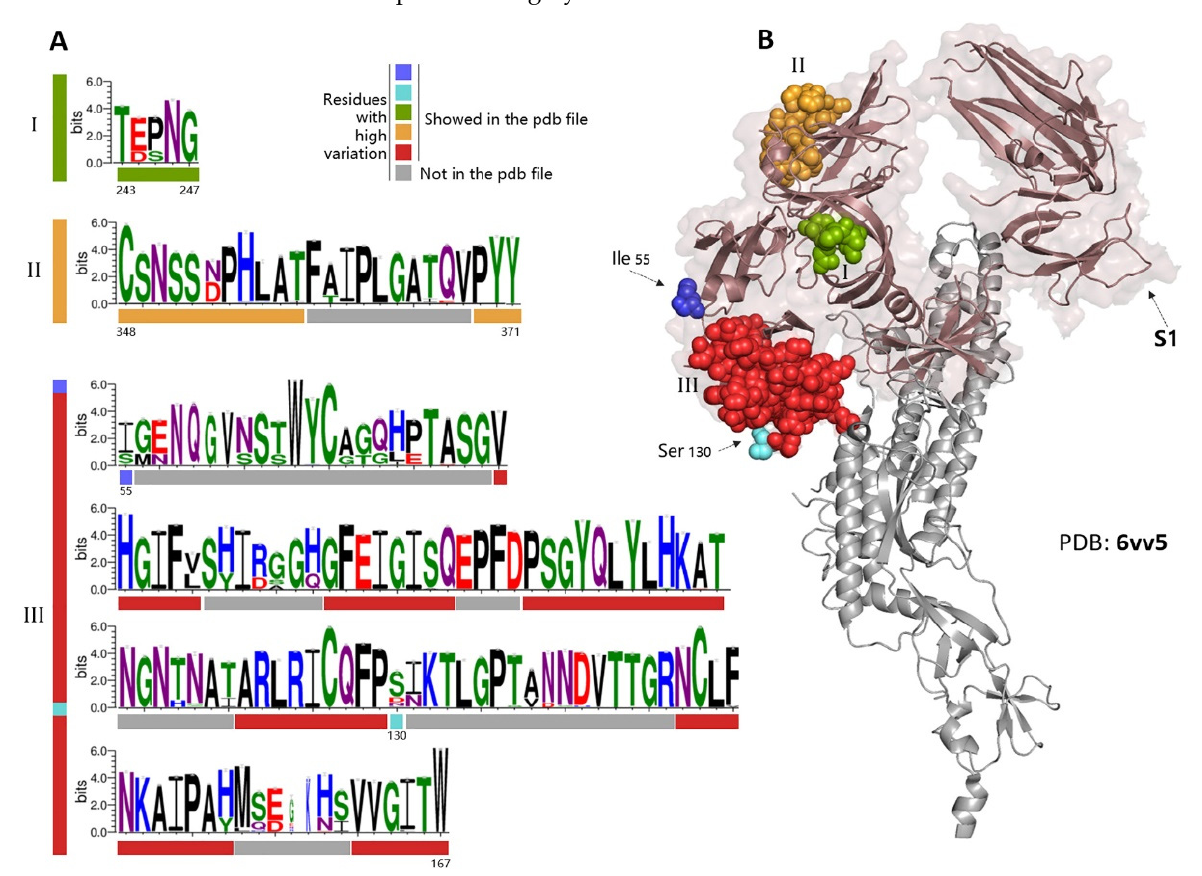
Figure 3. Schematic diagram of the highly mutated regions in PEDV S protein. ( A ) Highly mutated regions in the S protein, analyzed by a sequence logo generator WebLogo 3, were marked with different colors (I, II, and III), and the gray labeled sites indicted the uncontained sites in the PDB 6vv5, and ( B ) Corresponding locations of the highly mutated regions (I, II, and III) in the S protein based on the crystal structure file of PDB 6vv5; the brown transparent labeled area indicted the S1 domain.